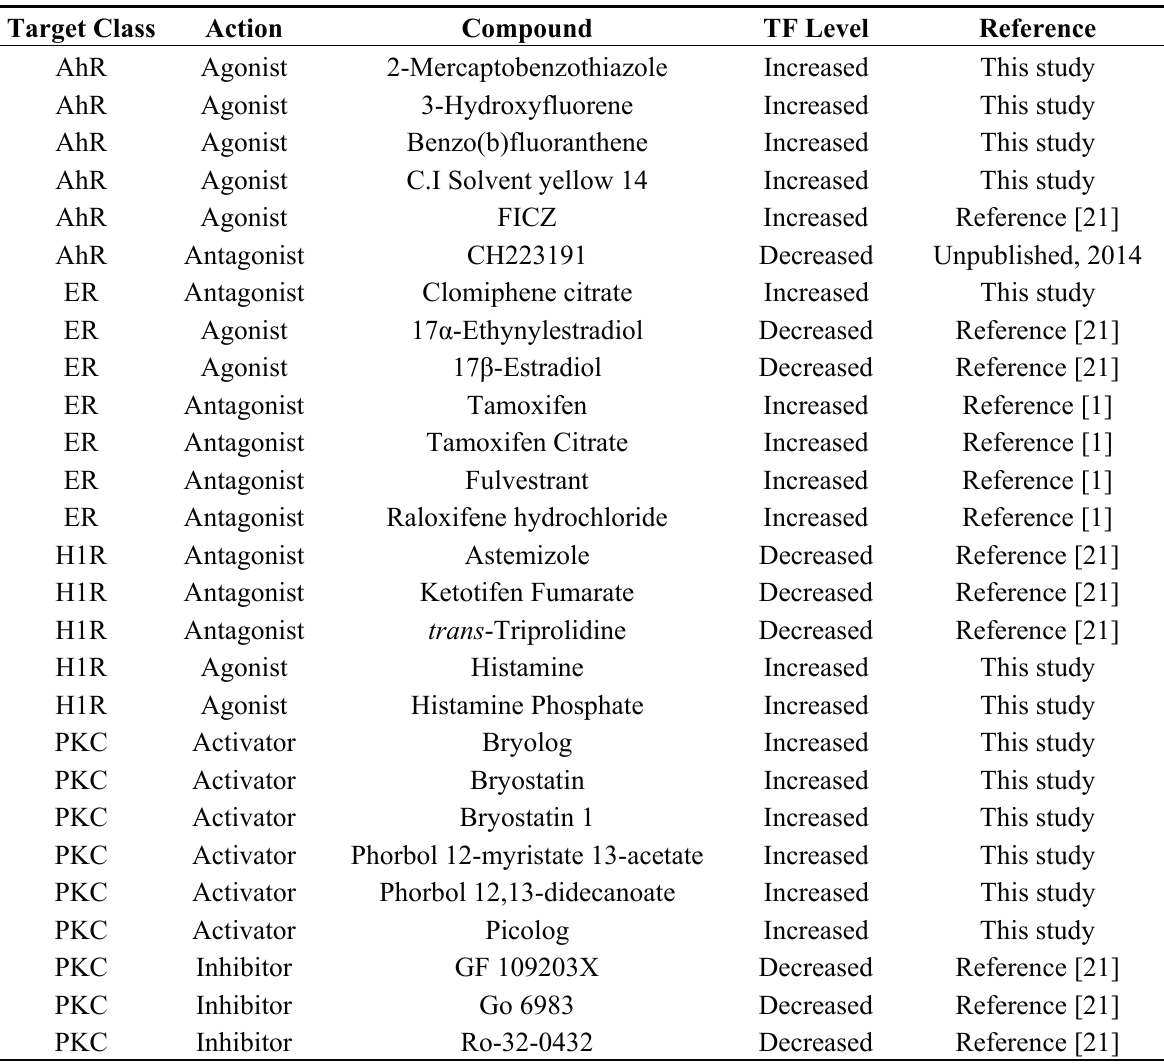
Table 2. List of target agonist and antagonist pairs that modulate cell surface levels of TF in the BioMAP 3C system in a reciprocal manner. Test agents listed increase TF at two or more concentrations as described in the Experimental Section, or significantly decrease the level of TF as